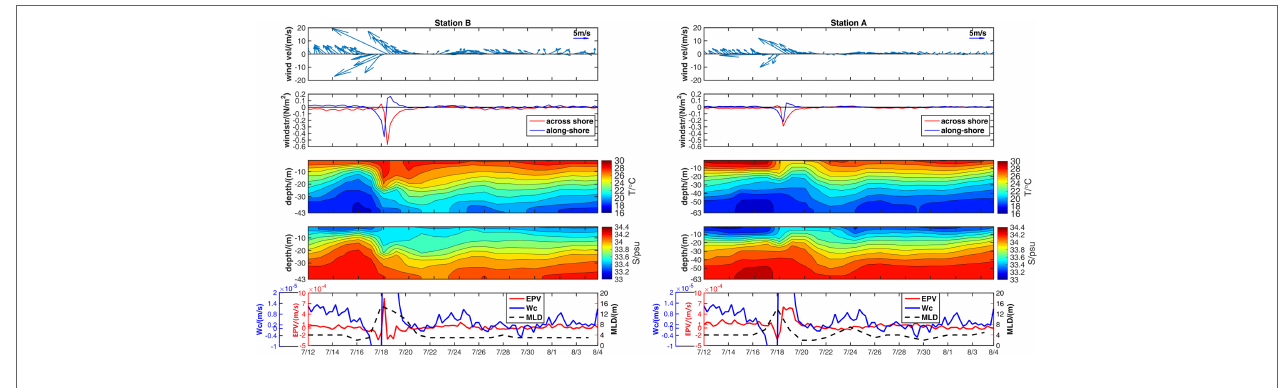
FIGURE 8 | Time series of (from top to bottom) wind vectors, wind stress, modeled vertical profiles of temperature and salinity, and mixed-layer depth together with Ekman pumping velocity (EPV) and coastal upwelling velocity (Wc) at stations (B) (left) and (A) (right).